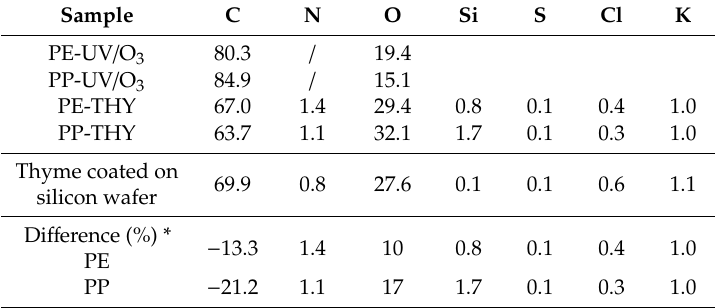
Table 4. Surface chemical composition of pristine and UV / ozone (UV / O 3 )-activated polymer foils and of foils coated with thyme (at. %).